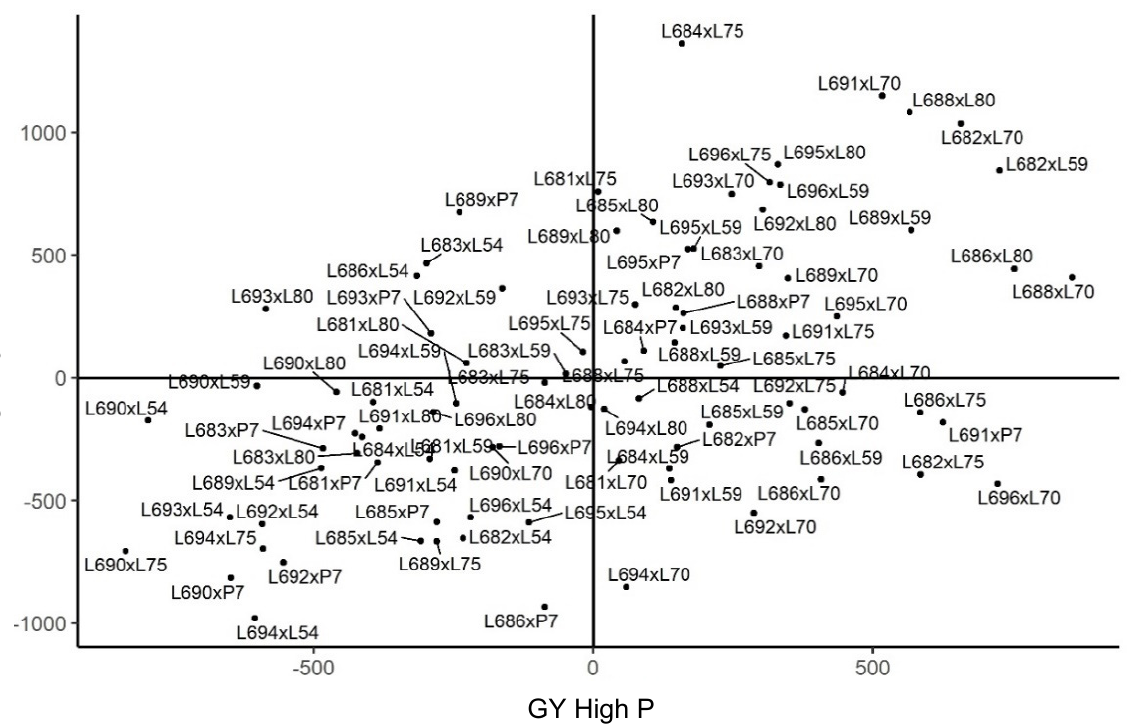
Figure 3. Estimates of the genotypic value ( 𝑠̂ (cid:3036)(cid:3037) ) of hybrids for grain yield (GY) in diallel hybrids of popcorn evaluated under high and low phosphorus availability in Campos dos Goytacazes. (-) signal indicating negative values.